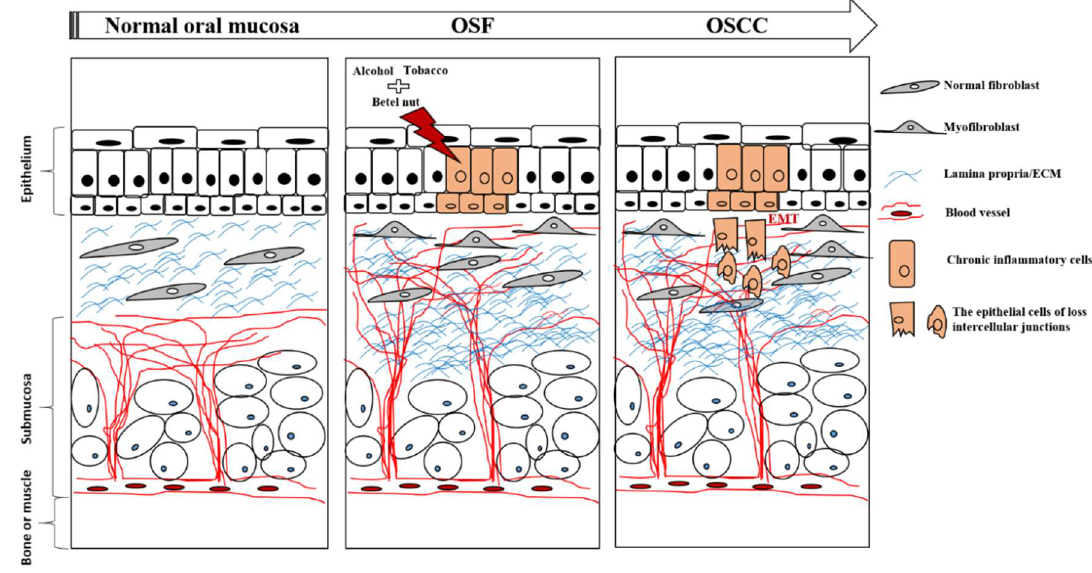
Figure 1. The molecular pathologic mechanism of oral submucous fibrosis (OSF).